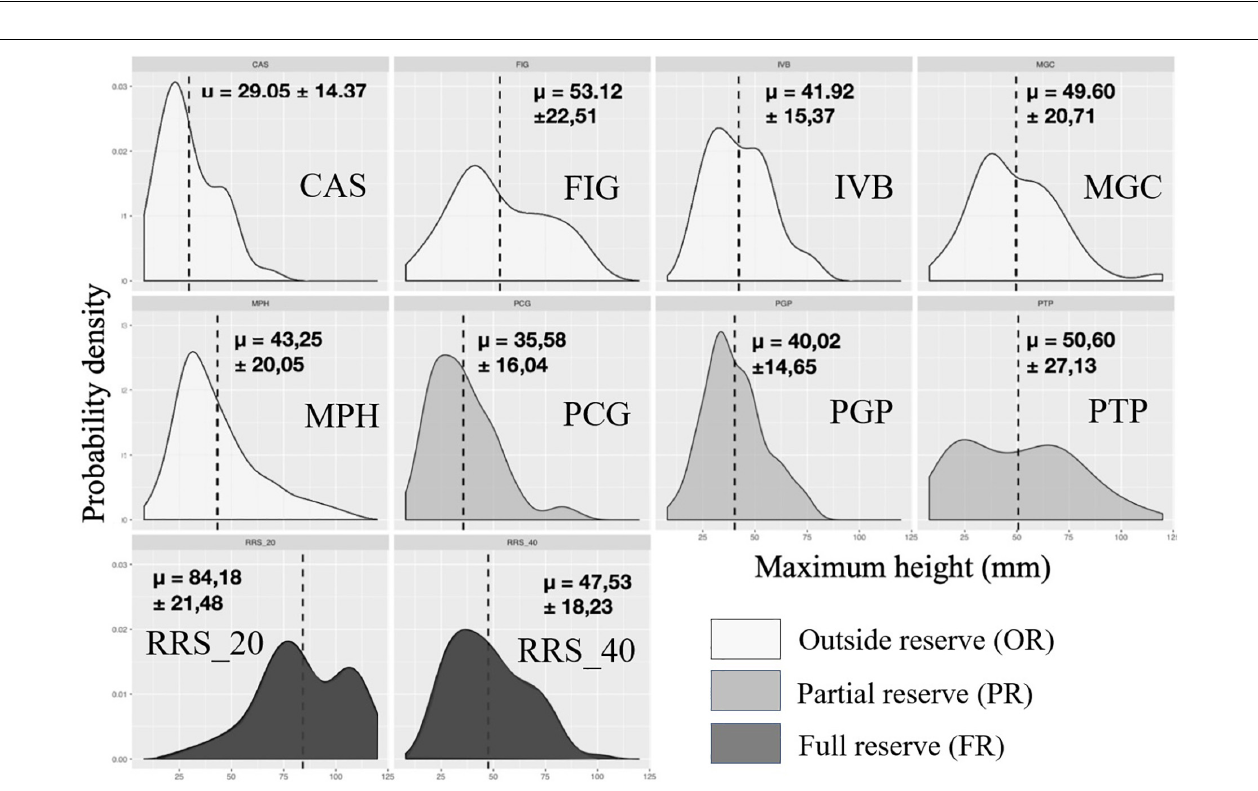
FIGURE 5 | Calanques national park: representation of probability density functions by population of each site for maximum height (mm) in 2020. The values indicated correspond to the means followed by the standard deviations. In dark the populations in full reserve (RRS_20; RRS_40), in medium the populations in partial reserve (PTP, PGP, PTP), in clear the populations outside the reserve (MPH, CAS, FIG, IVB, MGC).